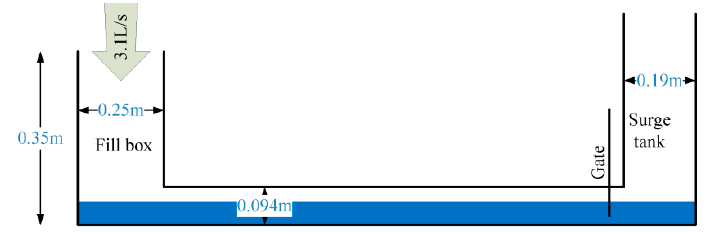
Figure 20. A sketch of the experimental setup.